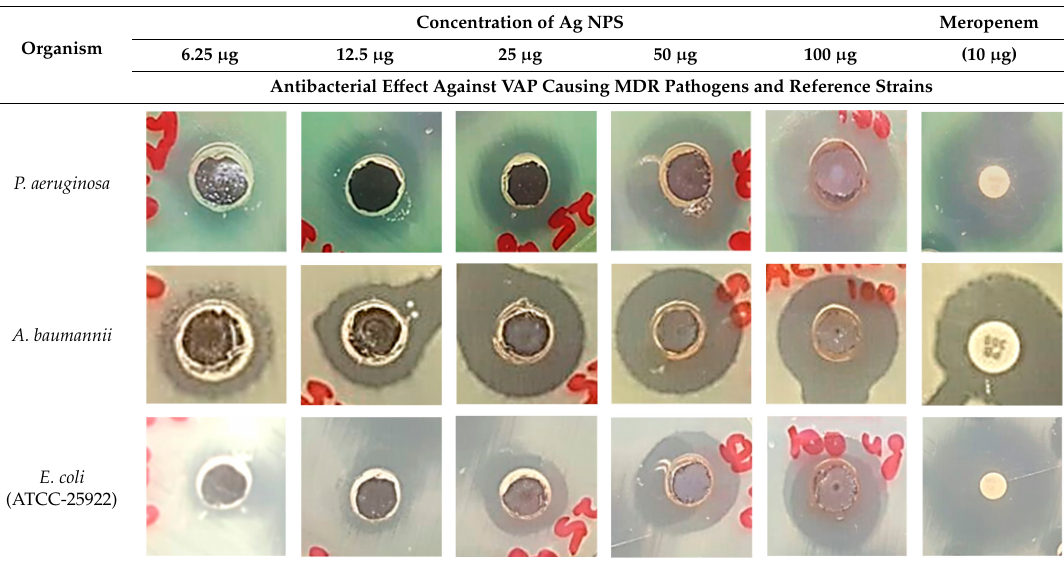
Table 2. Antibacterial activities of the synthesized Ag NPs against P. aeruginosa , A. baumannii, and E.